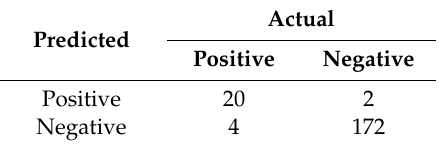
Table 4. Confusion matrix for model Fcara in an experiment.